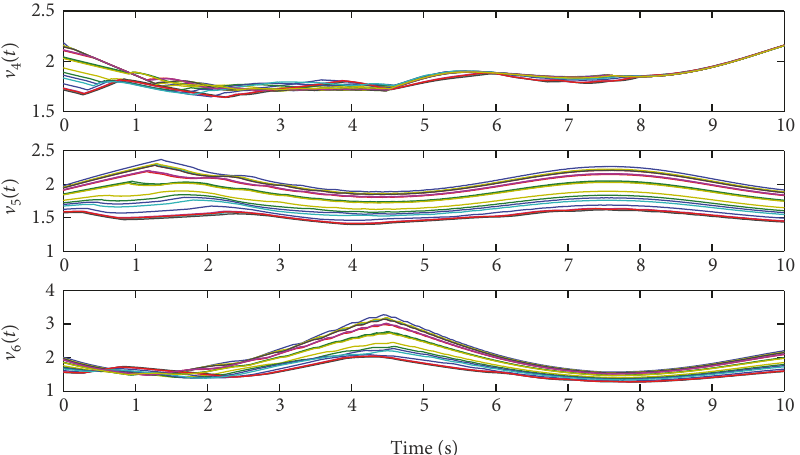
t , v t , and v t ) during closed-loop operation. 1 2 3